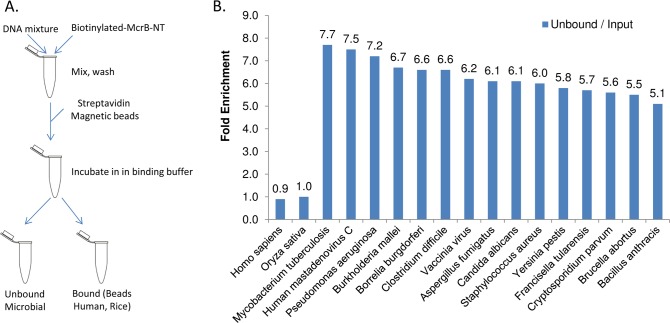
Enrichment workflow using McrB-N.(A) Biotinylated McrB-N enzyme is added to a DNA mixture. Following the addition of strepatavidin coated magnetic beads, the mixture is segregated into fractions that are bound (containing majority of human) or unbound (containing majority of microbes). (B) Sequence analysis demonstrates that McrB-N segregates human and rice DNA away from microbial genomes in the unbound fraction. The fold enrichment for each taxa is plotted for the unbound (blue) fraction.